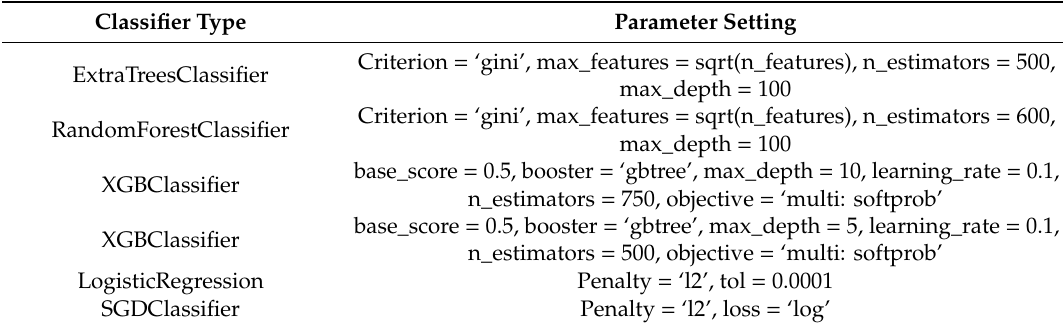
Table 15. Optimized classifier selection and its parameter